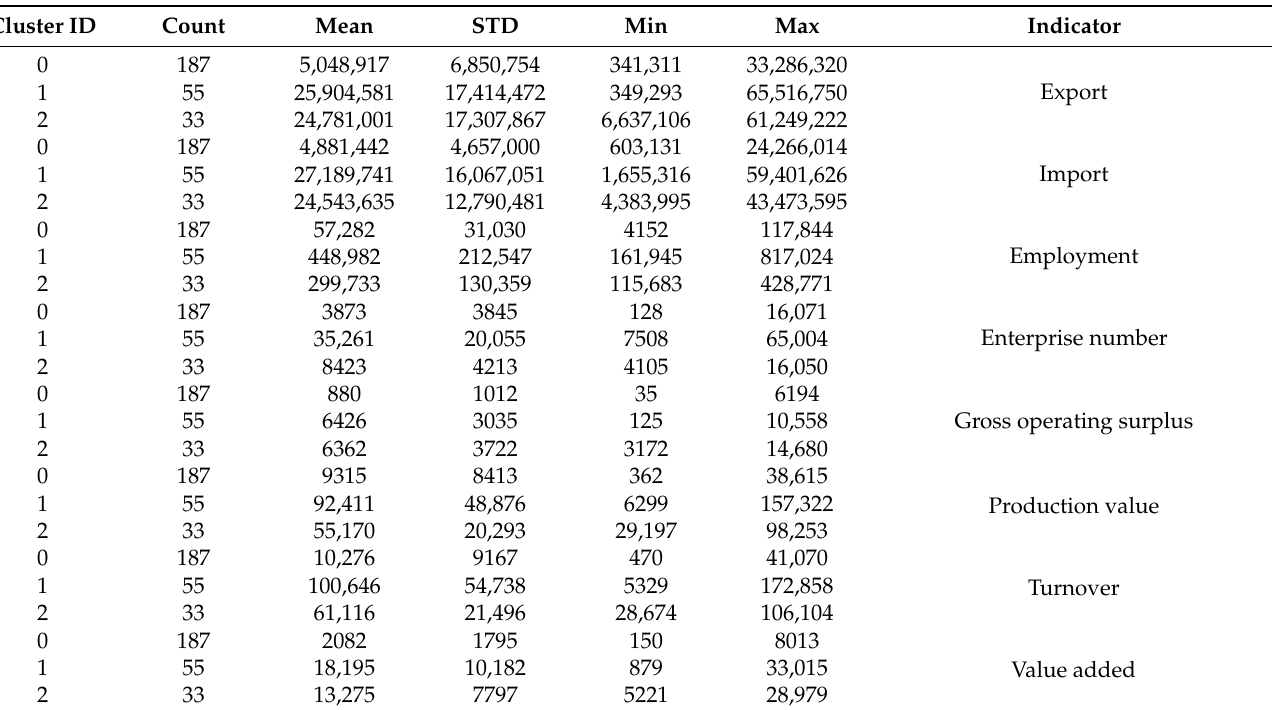
Table 4. Cluster group description by Food processing and manufacturing sector, created by